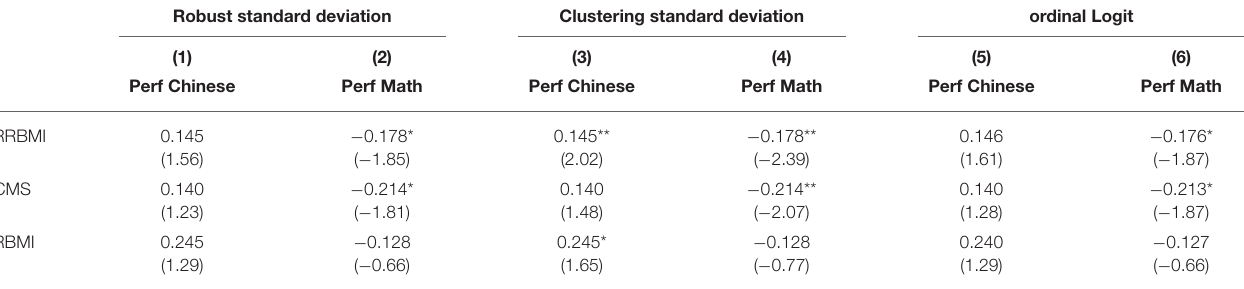
TABLE 5 | Robustness test of logit